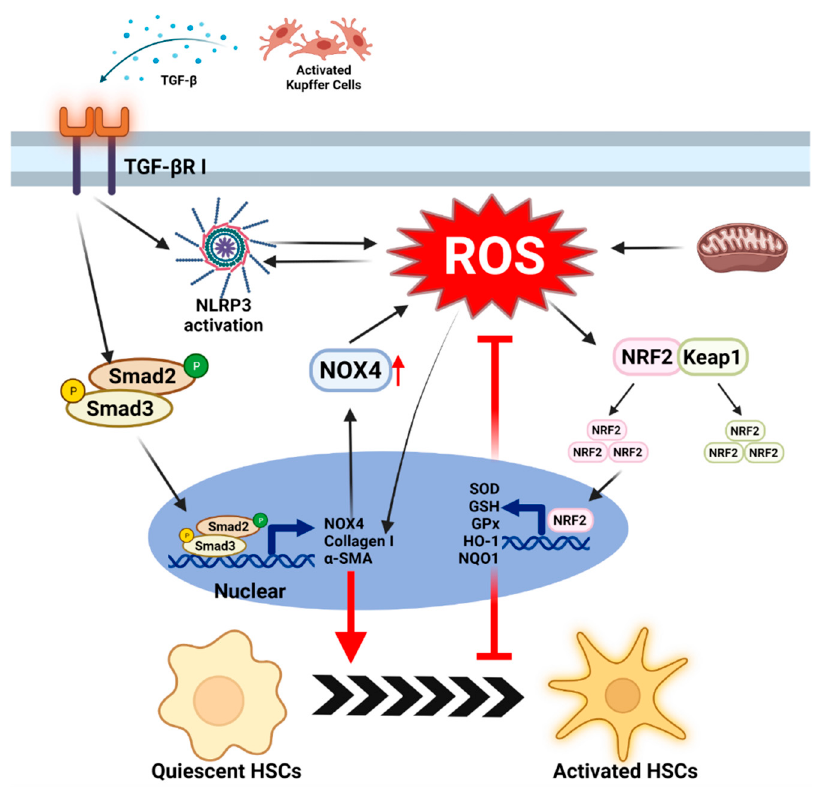
Figure 4. The mechanism of ROS in activation of stellate cells. TGF- β is released from activated KCs, the major cell type for cytokine production during NASH. the TGF- β -SMAD2/3 axis is activated in HSCs, which upregulates NOX4 expression to increase ROS production. The additional ROS directly drives the production of extracellular matrix (collagen-I and α -SMA) in HSCs. On the other side, TGF- β elevate NLRP3 activation to leads ROS production. The concomitant release of ROS from mitochondria exacerbates the activation of HSCs. Although moderate amounts of ROS can activate the dissociation of NRF2 and KEAP1 and drive NRF2 transcription, the NRF2-regulated antioxidant system can hardly resist the impact of large amounts of ROS in